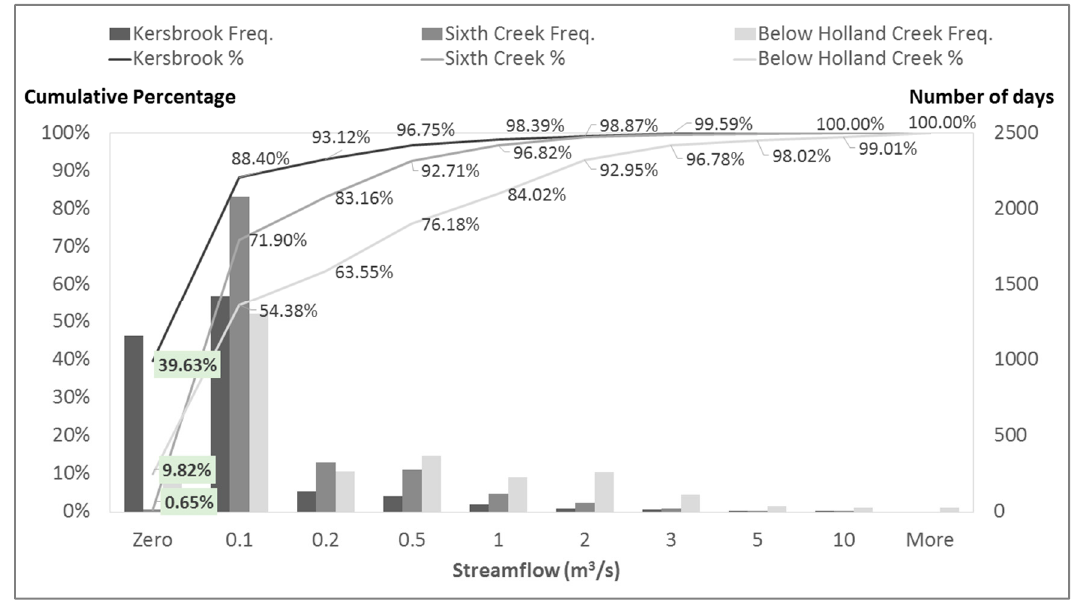
Figure 2. Frequency distribution of streamflows in the Kersbrook, Sixth Creek, and Below Holland Creek catchments.